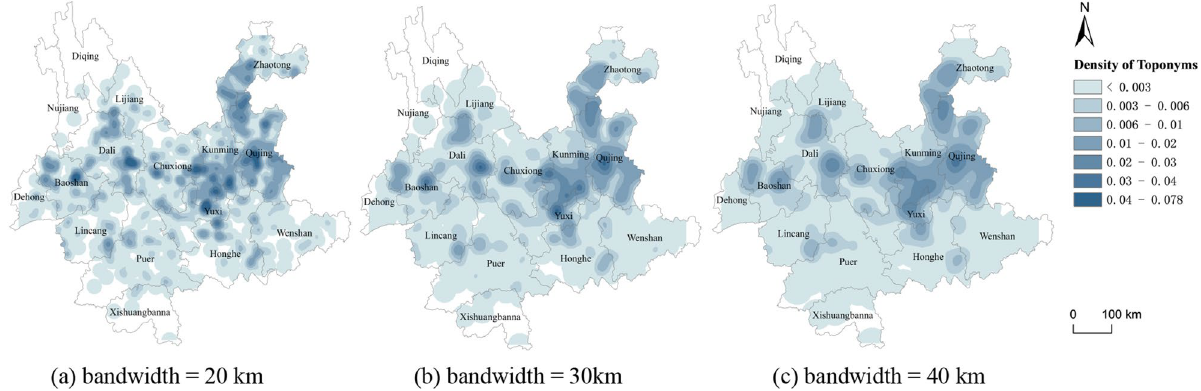
Figure 2. Kernel density of BTT with bandwidth of 20 km, 30 km, 40 km. Maps were created in ArcGIS Pro v.2.7: https:// www. esri. com (Esri, California, USA). The final layout was created in ArcGIS Pro v.2.7: https:// www. esri. com (Esri, California,